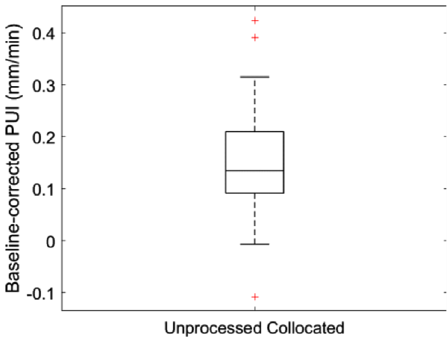
Figure 10. Baseline-corrected PUI measurement.